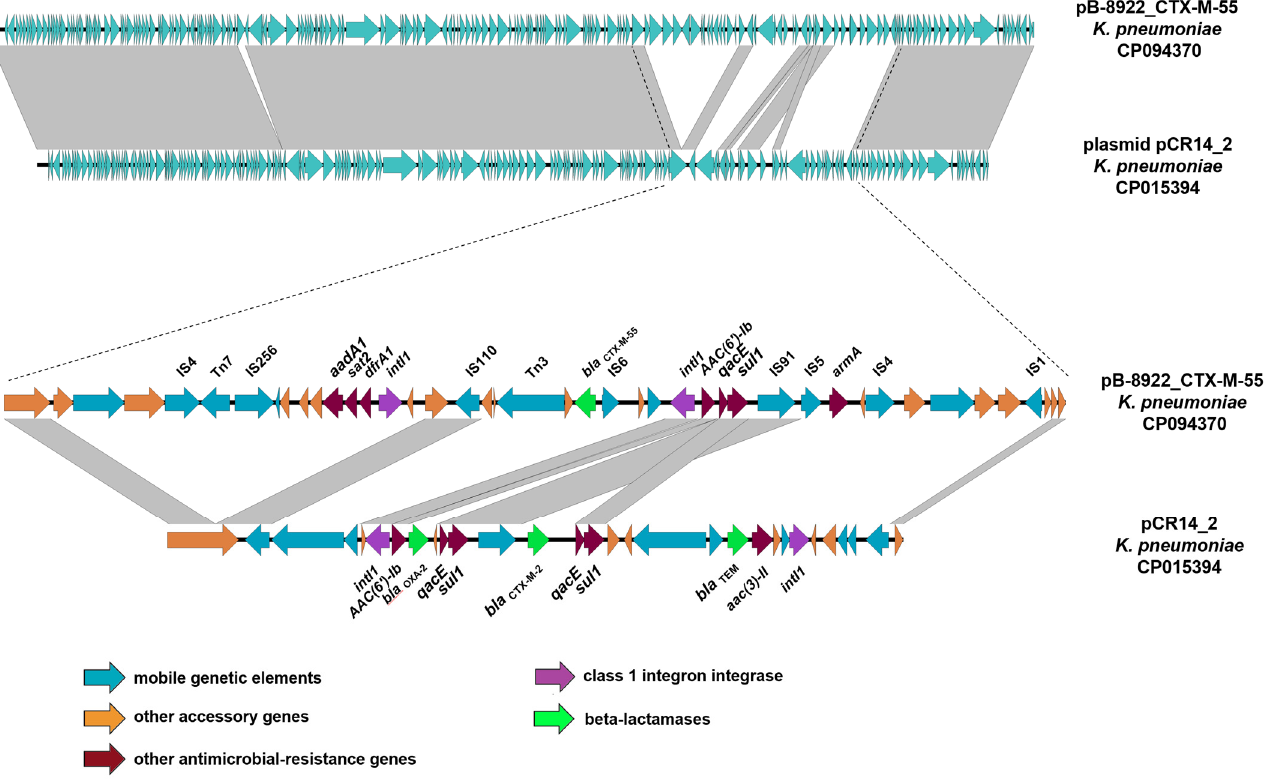
Figure 5. Easyfig of pB-8922_CTX-M-55 and plasmid pCR14_2 with the detailed genetic environ- ment of the gene bla CTX-M-55 . The arrows show the orfs , their length, and their